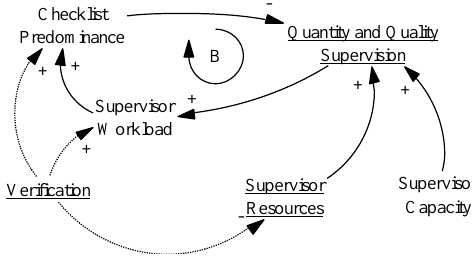
Figure 7. Causal loop diagram of “supervision conundrum” hypothesis.